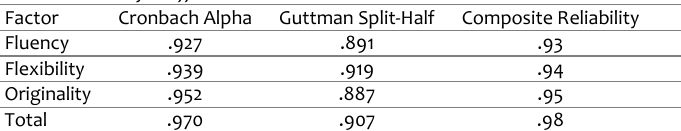
Table 6: Reliability